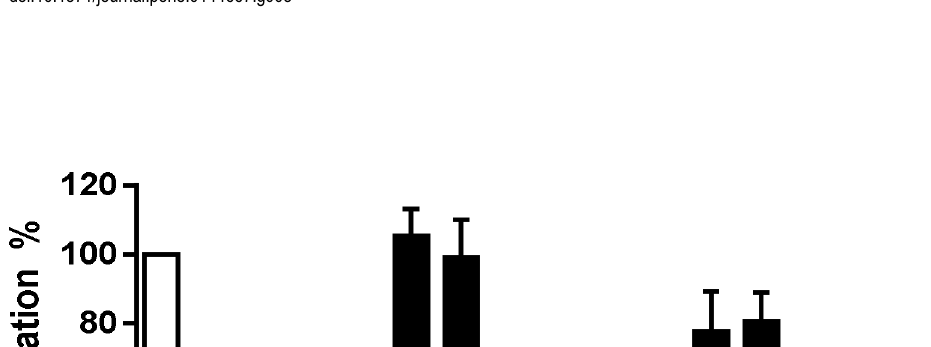
Fig 5. Trans-inhibition of OCT1 activity by Ro 31 – 8220. HEK-OCT1 cells were either untreated or exposed to 2 mM unlabelled TEA or 10 μ M Ro 31 – 8220 for 1 h. After washing, cells were next incubated with 40 μ M [ 14 C]TEA for 5 min at 37°C. Intracellular accumulation of labelled TEA was then determined by scintillation counting. Data are expressed as % of accumulation of TEA found in untreated control cells, set at 100%, and are the means ± SEM of four independent experiments. * , p < 0.05 when compared with untreated cells (ANOVA followed by Dunnett's post-hoc test).